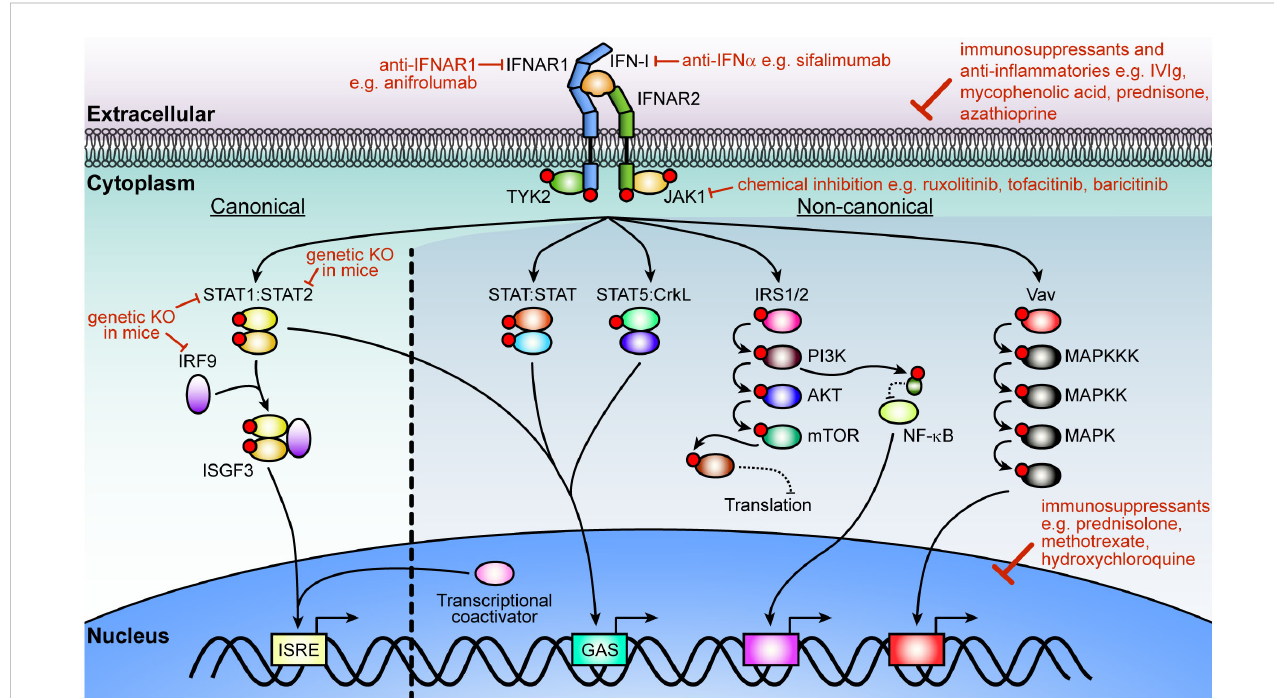
FIGURE 1 IFN-I signaling pathway and strategies of inhibition. After ligation of IFN-Is with its cognate receptor chains, IFNAR1 and IFNAR2, JAK1 and TYK2 transphosphorylate each other before phosphorylating the receptors. In the canonical pathway, STAT1 and STAT2 dock at the receptor to become phosphorylated by the JAKs. Phosphorylated STAT1 and STAT2 then form a trimolecular complex (ISGF3) with IRF9 and translocate into the nucleus to bind ISREs to regulate the expression of hundreds of interferon-regulated genes (IRGs). Non-canonical signaling involves homodimers or heterodimers of STATs, STAT5 binding to CrkL, or recruitment of transcriptional coactivators to regulate ISRE or GAS elements. Additional kinases are activated (PI3K, NF- k B and MAPK pathways) which modulate the cellular response to IFN-Is that includes translation of a subset of genes, regulation of transcription or a range of cellular functions. Multiple strategies have been employed to target IFN-I signaling including inhibition or elimination of proteins in the pathway or its overall effects with immunosuppressants and anti-in fl ammatories that act on the cell or affect the expression of genes associated with in fl ammation. Red circles indicate phosphorylation of a protein. IFN-I, type I interferon; IFNAR, IFN- a / b receptor; JAK1, Janus kinase 1; TYK, tyrosine kinase 2; STAT, signal transducer and activator of transcription; IRF9, interferon regulatory factor 9; ISFG3, interferon-stimulated gene factor; ISRE, interferon-stimulated response-elements; GAS, g -activated sequence; CrkL, Crk like proto-oncogene, adaptor protein; IRS, insulin receptor substrate; PI3K, phosphoinositide 3-kinase; mTOR, mammalian target of rapamycin; NF- k B, nuclear factor- k B; MAPK, mitogen-activated protein